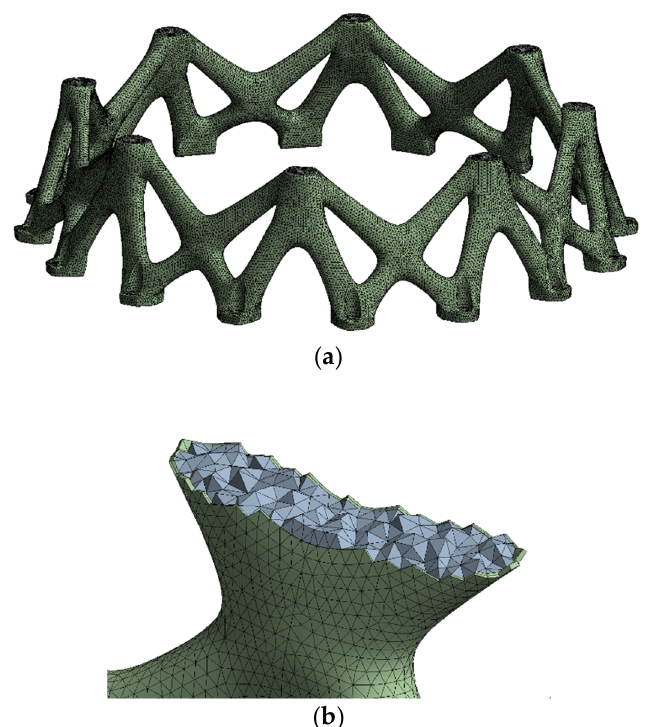
Figure 12. Homogenization analysis model with a total of 85,000 nodes: ( a ) full model; ( b ) internal model.